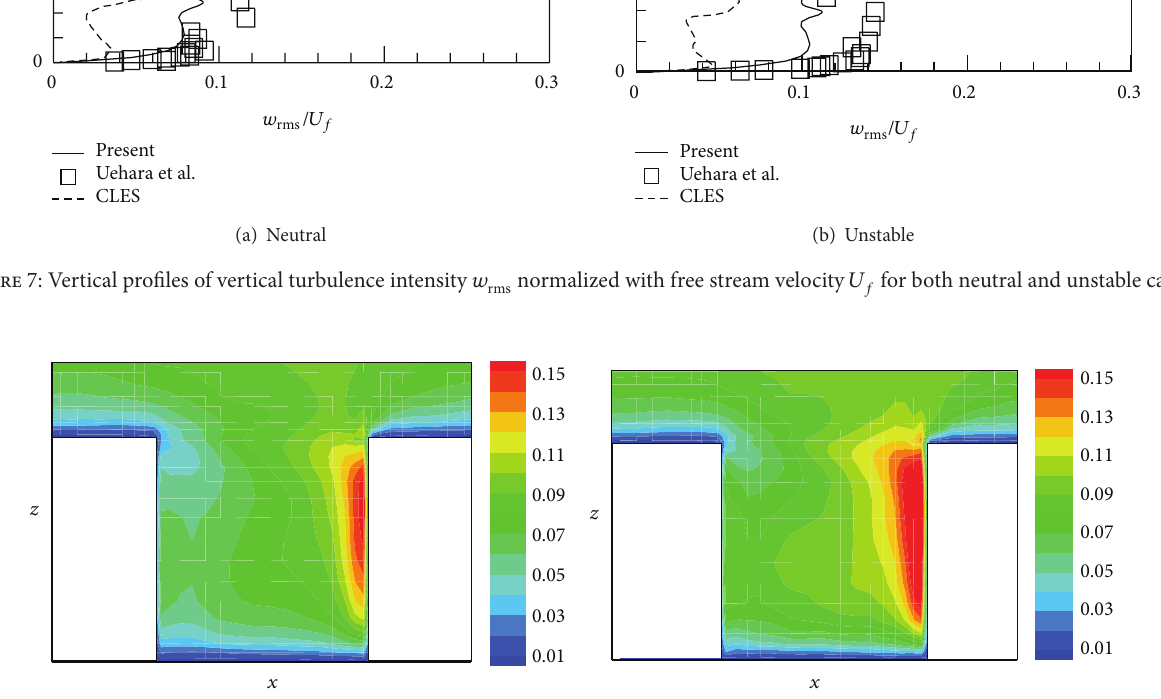
normalized with free stream velocity 𝑈 𝑓 on vertical plane through the middle of the